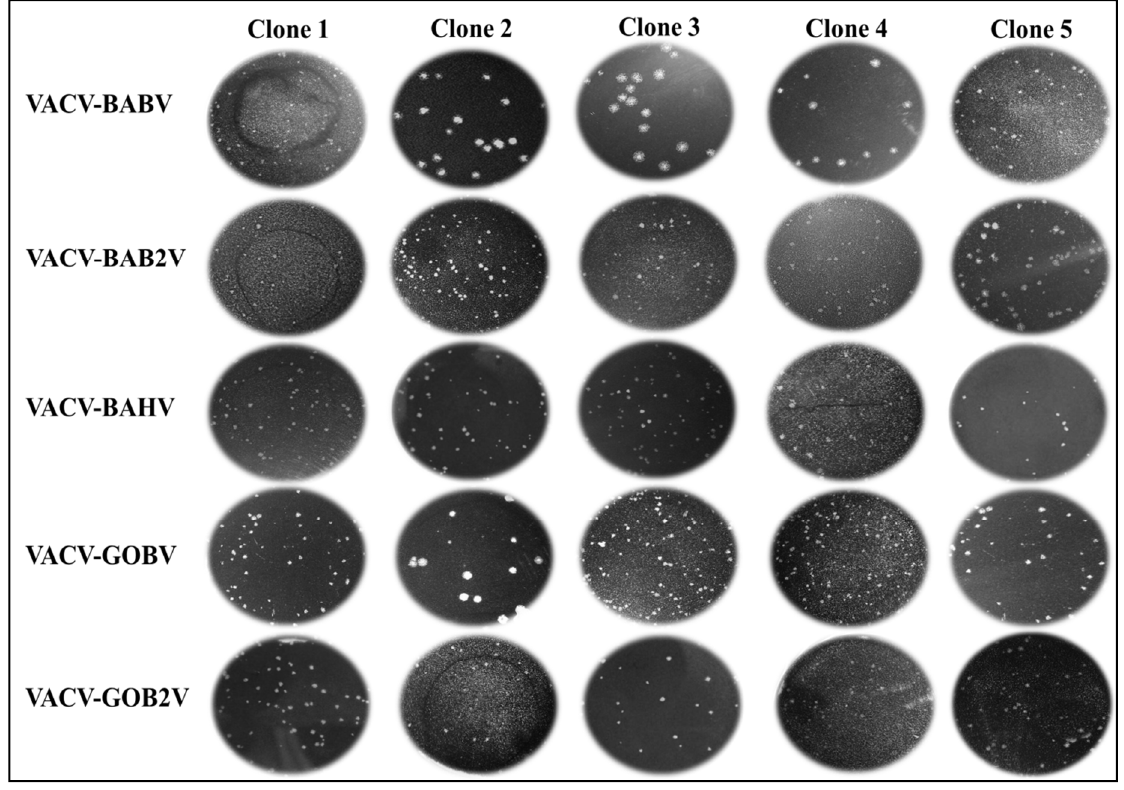
Figure 2. Viral clone plaque phenotype assays. BSC40 cells were cultured in a 6-well dish and then infected with VACV clones. Infection was carried out in the presence of